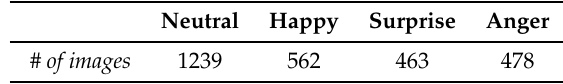
Table 1. Number of images per type of emotion considered in our study.